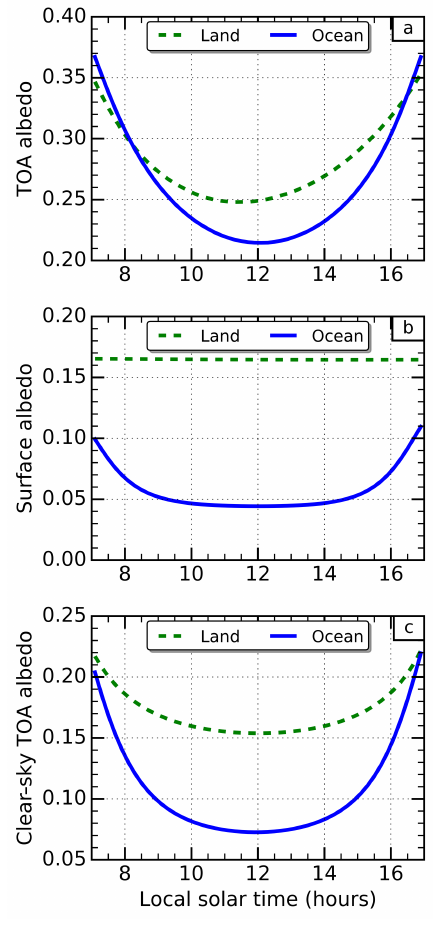
Figure 6. The diurnal cycle of global mean albedo for Septem- ber 2010 in the Met Office model for (a) top-of-atmosphere (TOA) all-sky, (b) surface and (c) TOA clear-sky albedo, separated over land (green dashed line) and ocean (blue solid line).